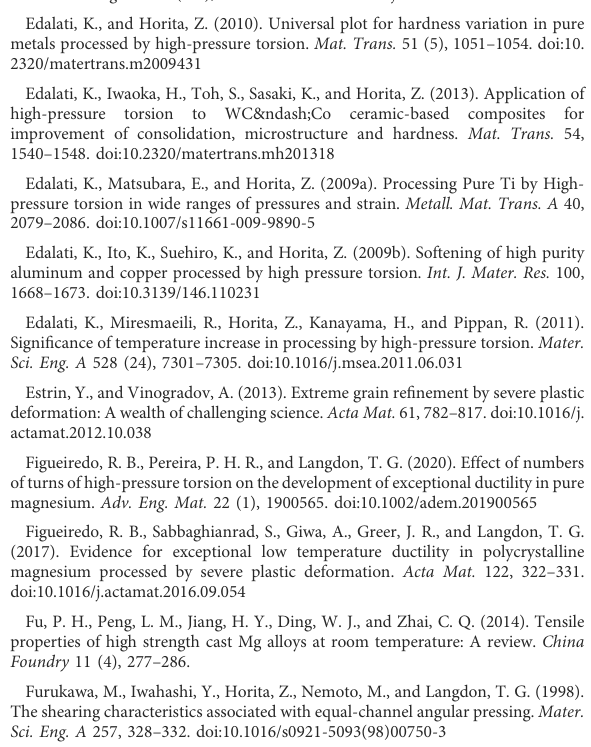
Figueiredo, R. B., Pereira, P. H. R., and Langdon, T. G. (2020). Effect of numbers ofturnsofhigh-pressuretorsiononthedevelopmentofexceptionalductilityinpure magnesium. Adv. Eng. Mat. 22 (1), 1900565. doi:10.1002/adem.201900565 Figueiredo, R. B., Sabbaghianrad, S., Giwa, A., Greer, J. R., and Langdon, T. G. (2017). Evidence for exceptional low temperature ductility in